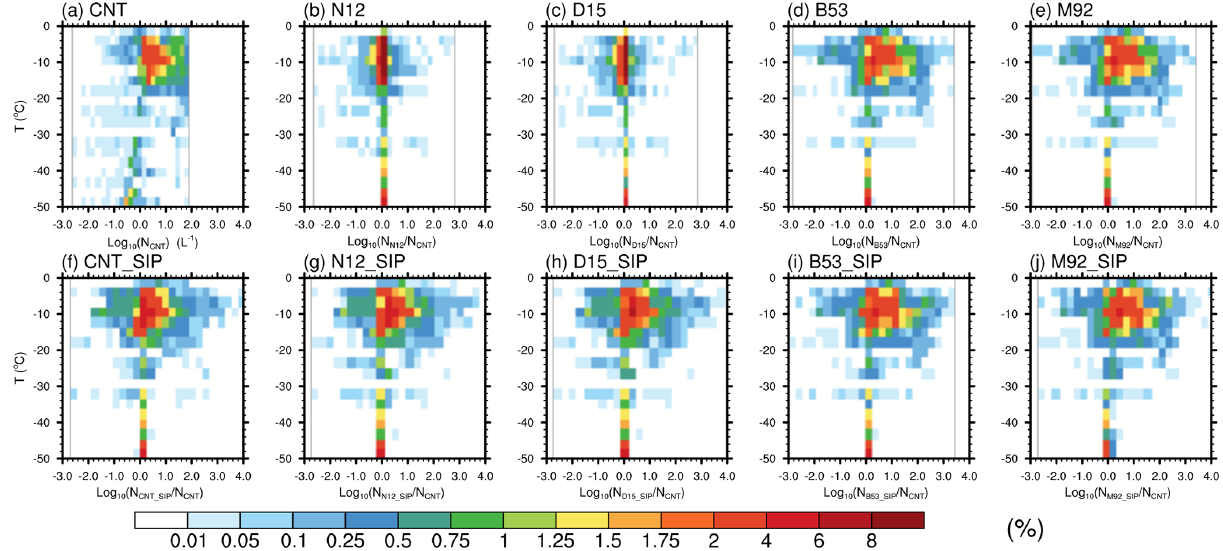
Figure 5. Bivariate joint probability density functions (PDF) in terms of both temperature and (a) ice crystal number concentration (L − 1 ) from the CNT experiment, and (b–j) in terms of both temperature and enhancement ratio of ice crystal number concentration from the respective experiment to that from the CNT experiment. A logarithmic scale is used for the x